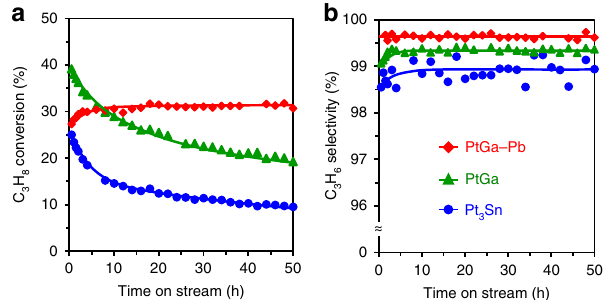
Fig. 4 Catalytic performance in PDH. a , b Changes in propane conversion ( a ) and propylene selectivity ( b ) in PDH catalyzed by PtGa/SiO 2 , PtGa – Pb/ SiO 2 (Pt/Pb = 2), and Pt 3 Sn/SiO 2 are shown. Catalyst amount was adjusted so that the number of exposed Pt was identical (4.5 μ mol): PtGa (9.0 mg), PtGa – Pb (Pt/Pb = 2) (15 mg), Pt 3 Sn (3.7 mg), and diluted with quartz sand (total 1.5 g). Gas feed: C 3 H 8 :H 2 :He = 3.9:5.0:40 mL min − 1 . Temperature: 600